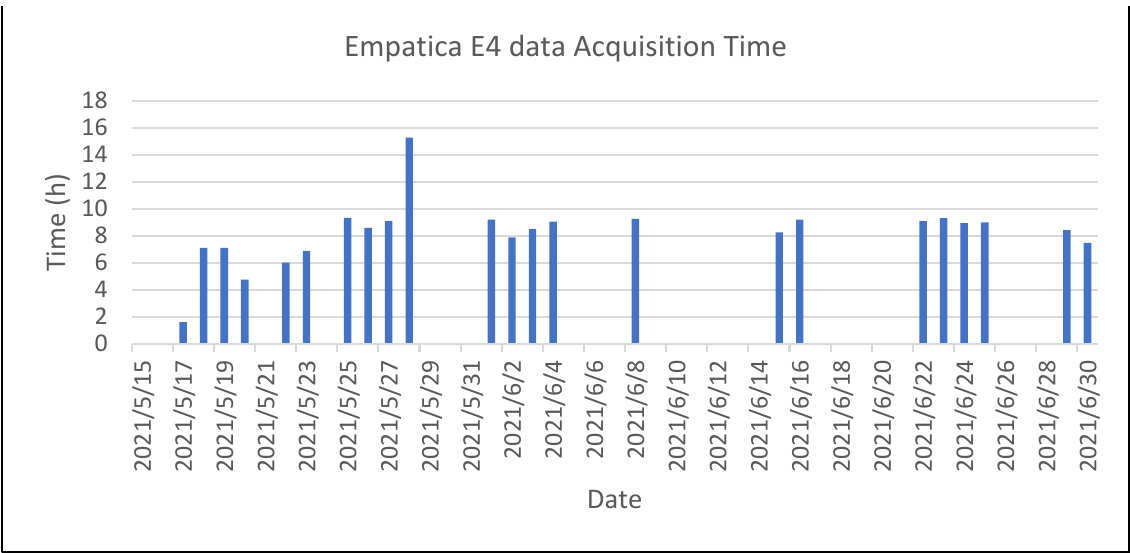
Figure 13. Duration of sessions recorded with the Empatica E4 medical device for the first subject. As can be seen, during the first phase (Figures 14 and 15) of the study, there were many days when the user did not answer the proposed